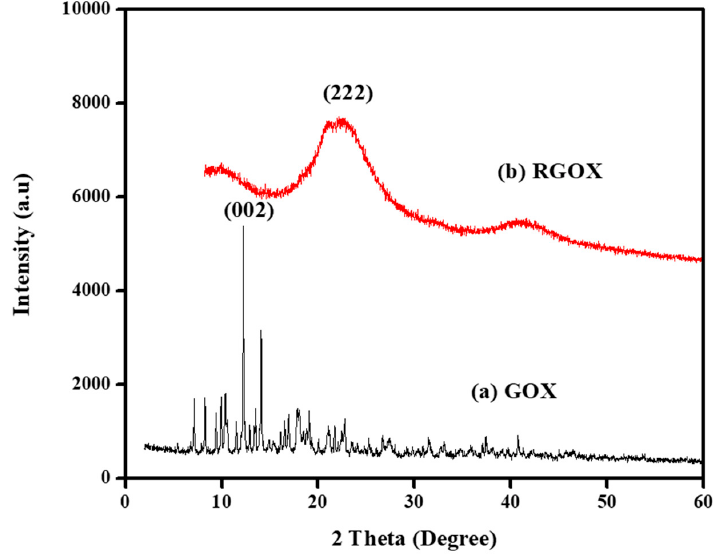
Figure 3. XRD graph of ( a ) GOX and ( b ) RGOX.